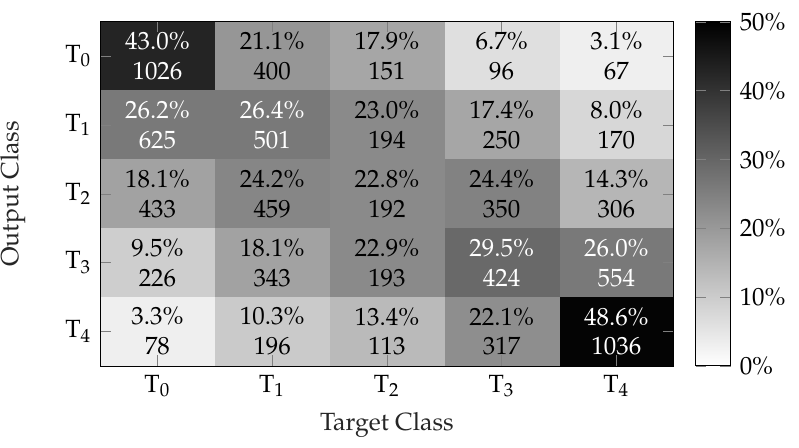
Figure 8. Multi-class classification performance (confusion matrix) of the fusion architecture (Late Fusion (b)). The darker the color the higher the corresponding performance. Table 6. EDA performance comparison to early work on the BVDB (Part A) in a LOSO cross-validation setting.